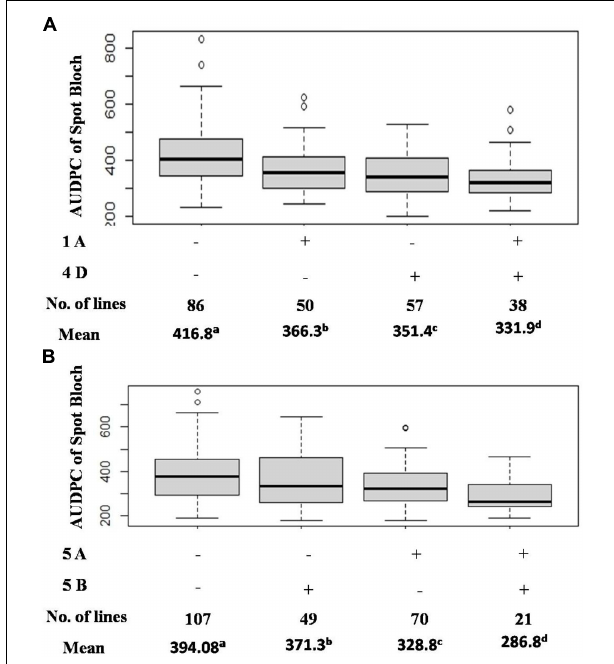
FIGURE 3 | Effects of QTL combinations in reducing AUDPC in the BC (A) and CC (B)